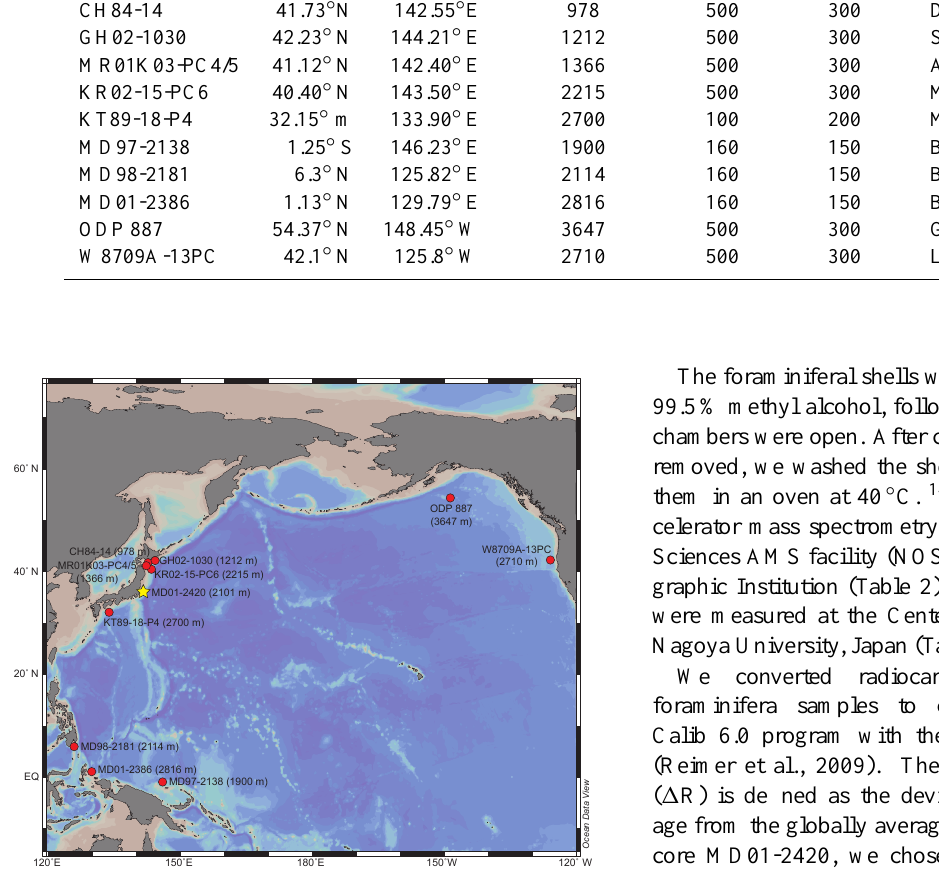
Fig. 1. Okazaki et al.